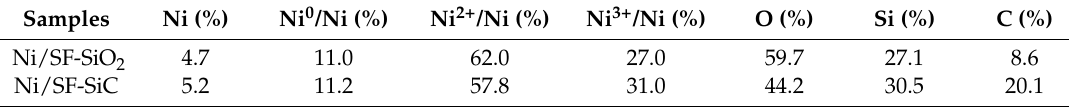
Figure 6. Ni 2p ( a ), O 1s ( b ), Si 2p ( c ) and C 1s ( d ) XPS spectra of the freshly reduced Ni/SF-SiO 2 and Ni/SF-SiC. Table 4. Elemental analysis of Ni, O, Si, and C elements content by X-ray photoelectron spectroscopy